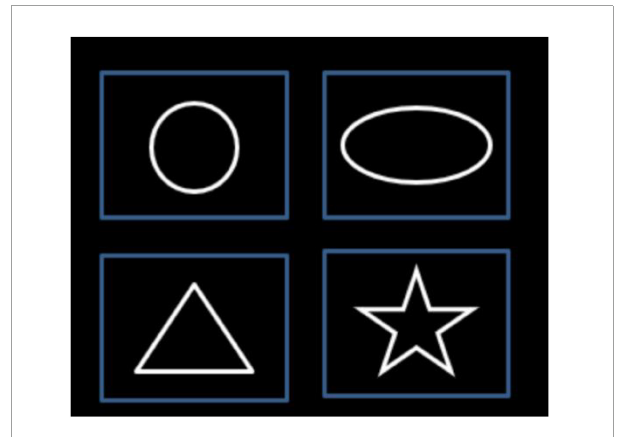
FIGURE1 Four shapes, circle and ellipse as circular type, and triangle and star as angular type. Each of the shapes was displayed randomly as visual stimuli in the